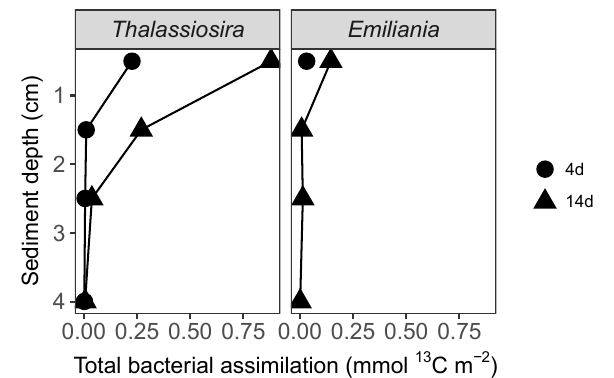
Figure 3. Total assimilation of algal carbon (mmol 13 Cm − 2 ) in bacterial biomass in the sediment of the 4 and 14-day Emiliania and Thalassiosira experiments. For the 4-day Emiliania experi- ment, only the first sediment centimetre was available for